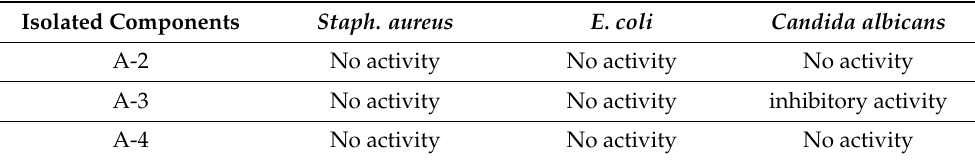
Table 6. Antimicrobial activity of isolated components A-2, A-3, and A-4 using the disc diffusion method. Isolated Components Staph.